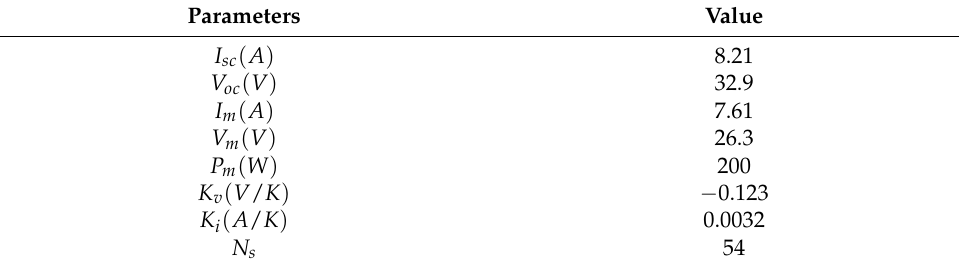
Table 2. Specifications of Kyocera-KC200GT at